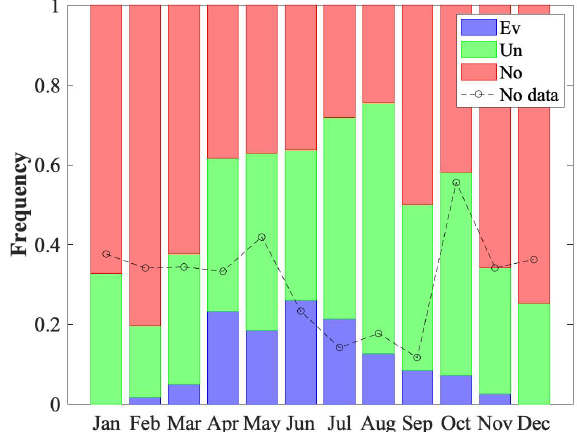
Figure 2. Seasonal distribution of event days (Ev, blue), undefined days (Un, green), and non-event (No, red) days at the ATOLL sta- tion, Lille, France, during 2017–2020. Days with missing data are excluded from the total number of days per month and the frequency of missing data are indicated with the black